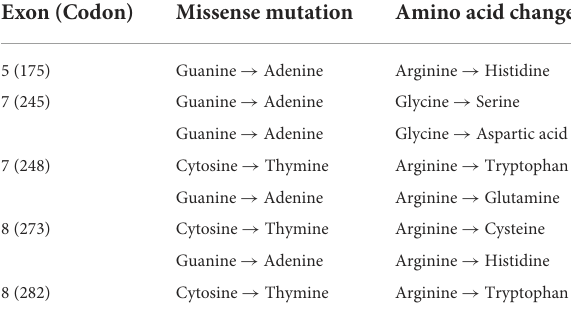
TABLE 3 Several common codons that are vulnerable to cellular stress leading to missense mutations